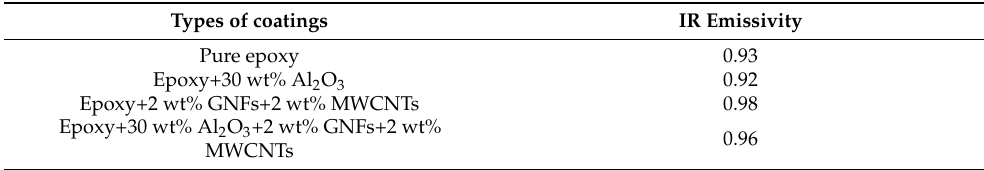
Table 1. Infrared emissivity of various prepared coatings.